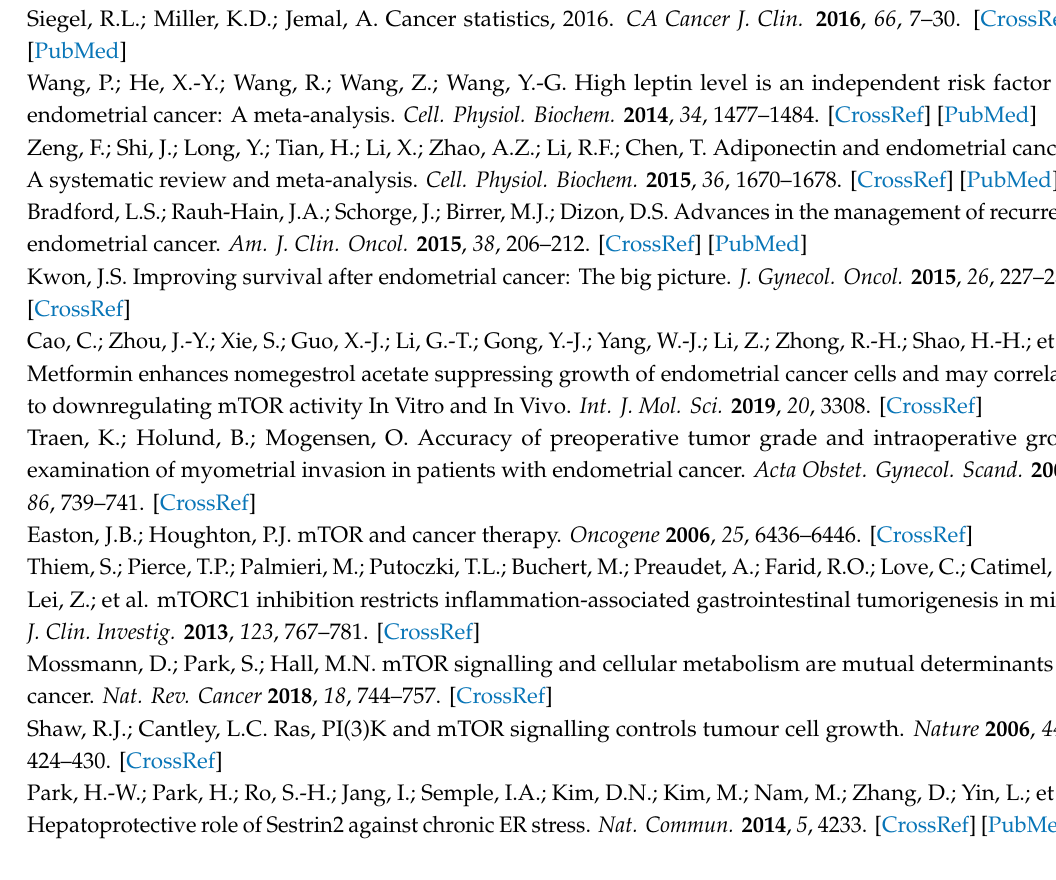
Figure S1: E ff ect of SESN2 overexpression on EMT in HEC-1A cells with SESN2